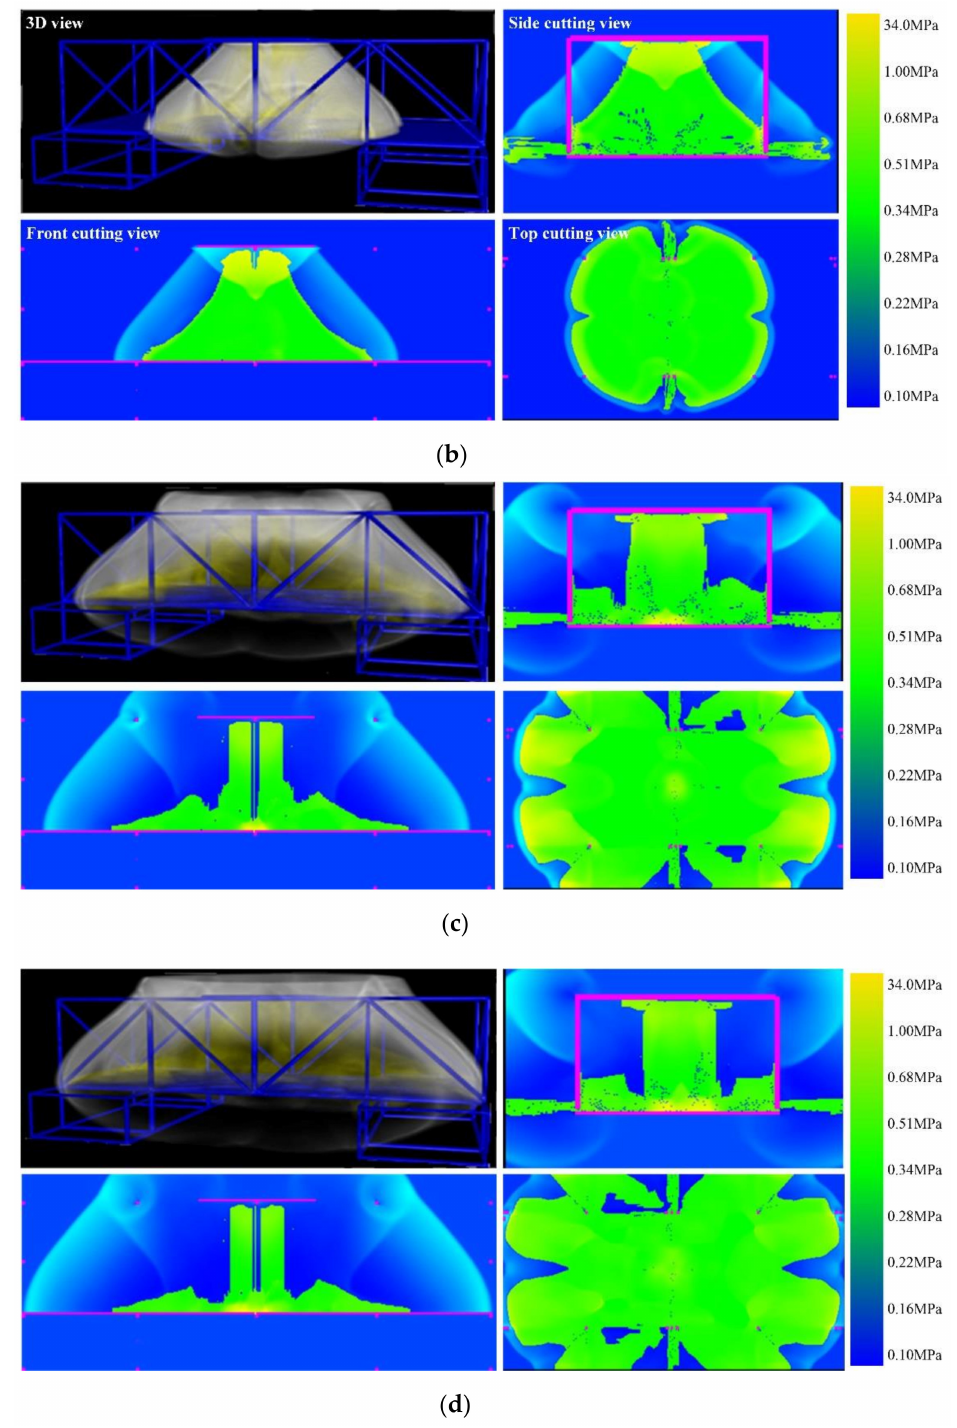
Figure A1. Explosion shock wave propagation images at different times without explosion